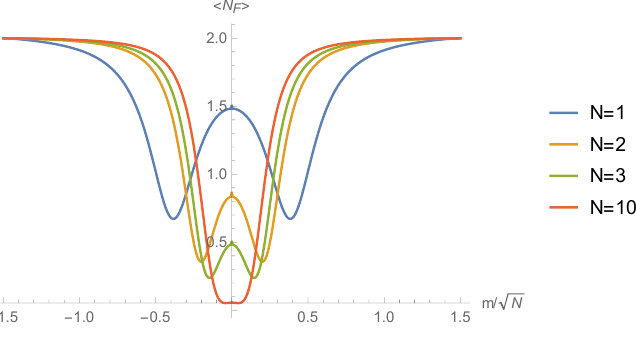
Figure 3 . For a deformation corresponding to turning on a bulk pseudoscalar (cid:12)eld, N F ( m ).